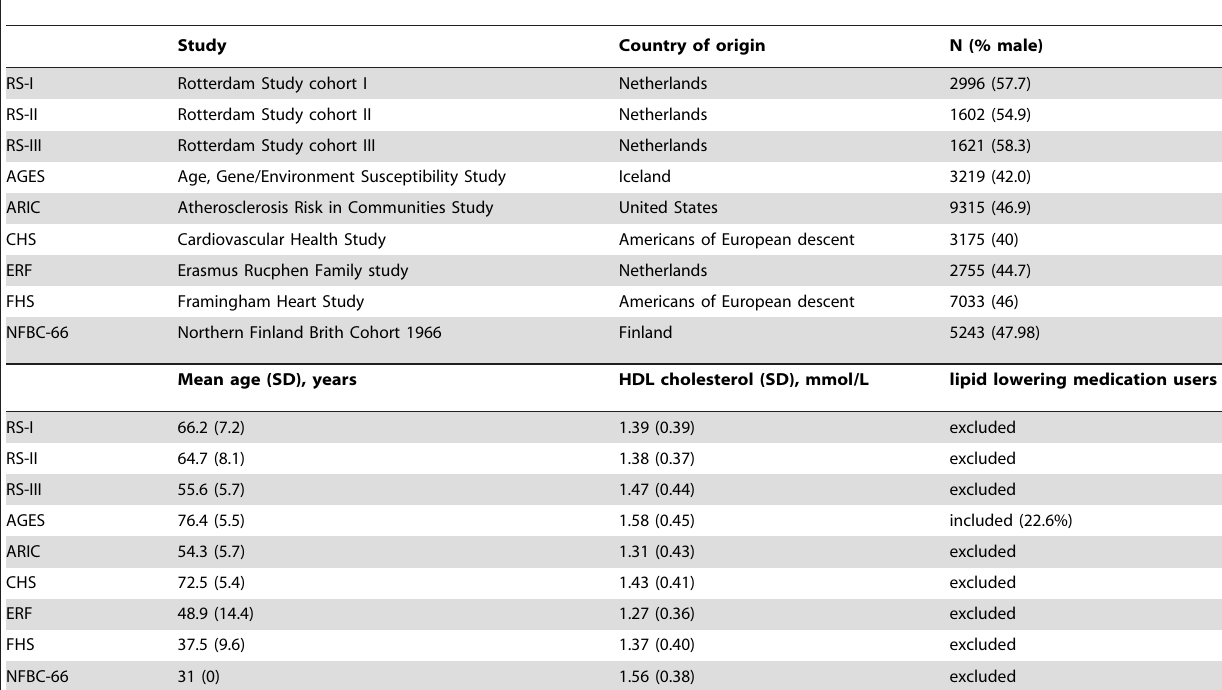
Table 1. Baseline characteristics for discovery and replication